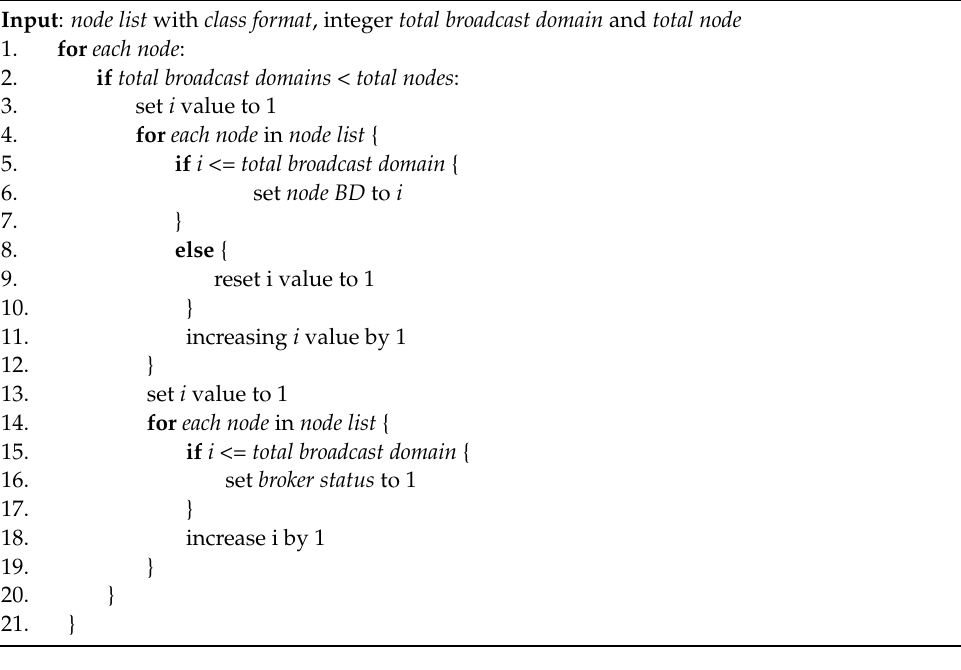
Algorithm 1 . BD and broker allocation.